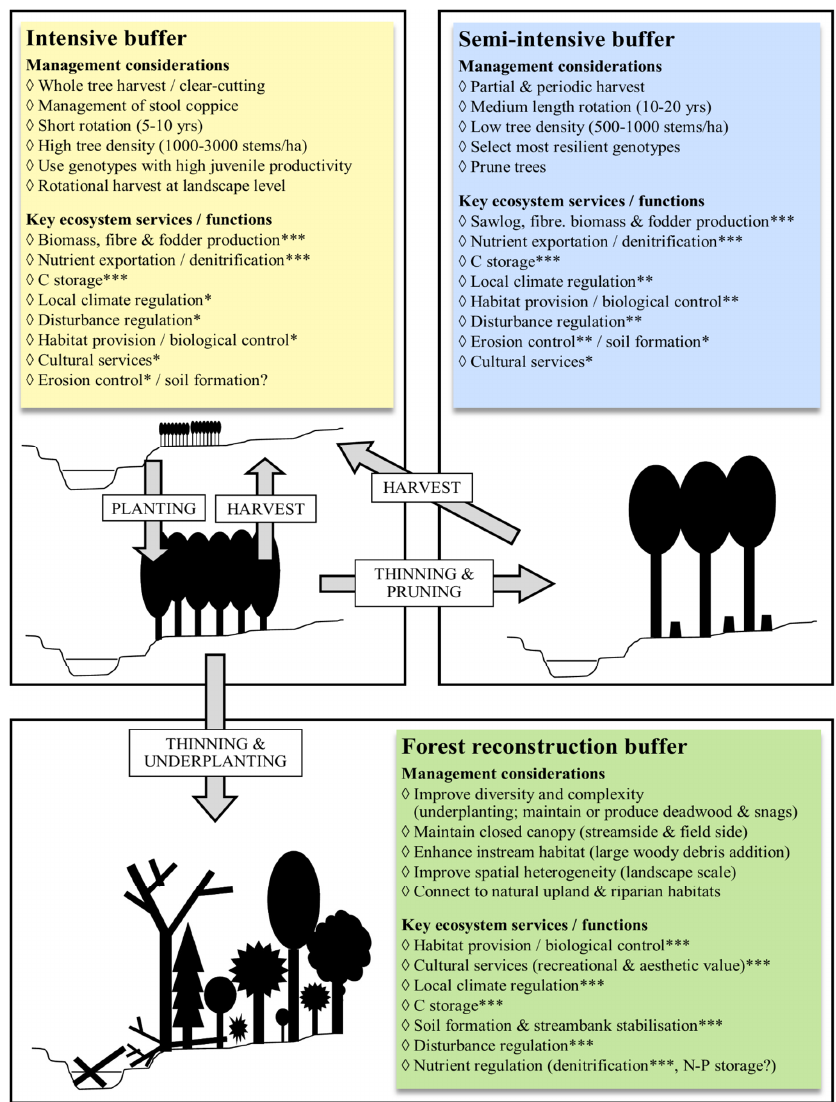
Figure 6. Examples of the different management options available following hybrid poplar buffer establishment in agricultural riparian zones. Potential levels of ecosystem service or function supply within the different buffer management types are indicated (* low; ** moderate; *** high, ? uncertain).